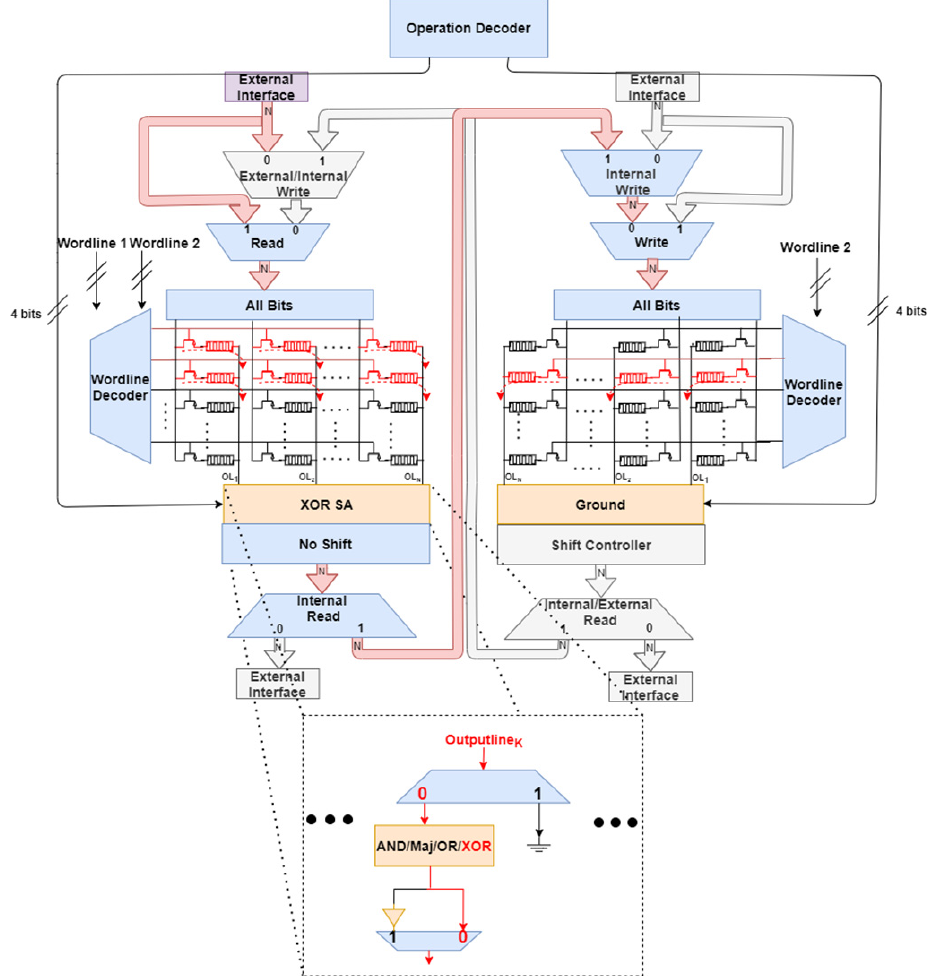
Figure 10. Configuration of the system’s modules to perform word-wise XOR operation with simultaneous storage of results to the adjacent sub-array. Text in blocks reveals the actual action performed in all modules. Inactive modules are shown in a light gray shade. The active wordlines in the two sub-arrays and the valid SA configuration (shown in the inset) are highlighted in red color.